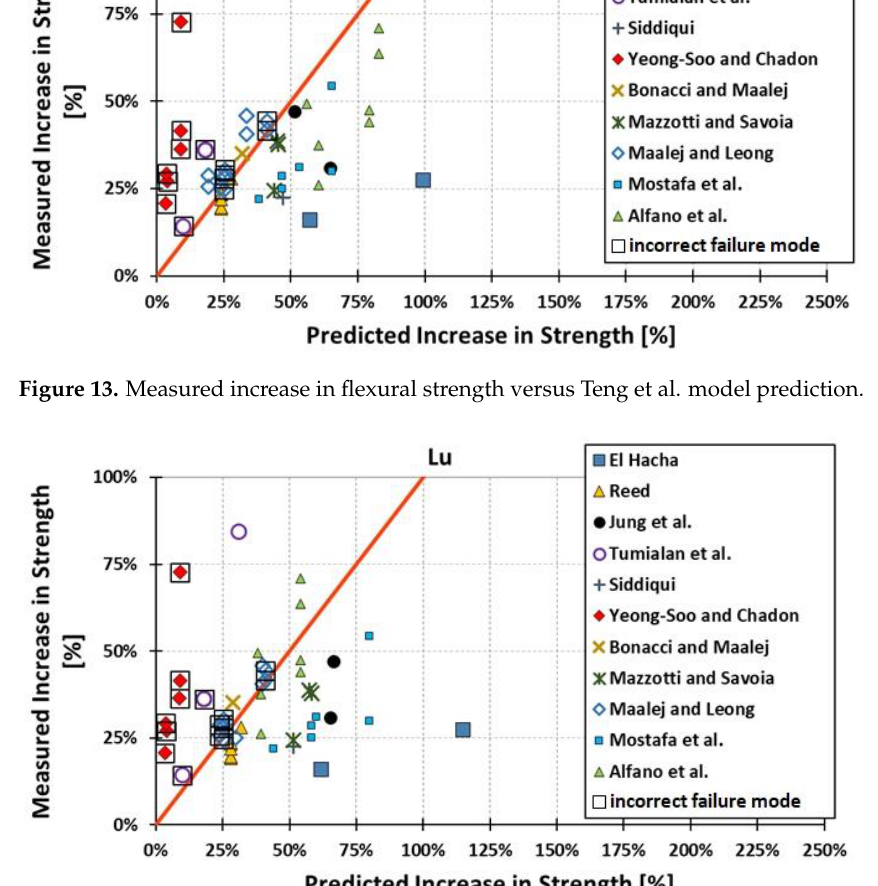
Figure 14. Measured increase in flexural strength versus Lu model prediction.